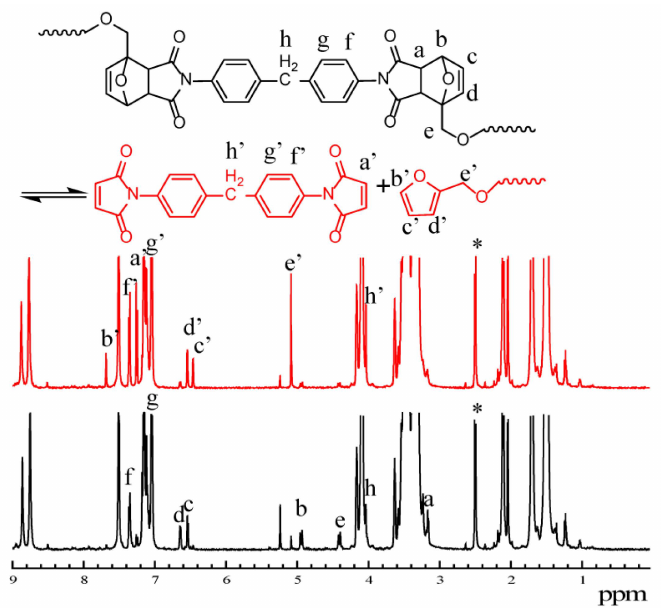
Figure 7. 1 H NMR spectra of PET-DA-PU during the heating procedure at 100 ◦ C for 20 min. (PET-DA- PU was marked as black, and PET-DA-PU after heat treatment was marked as red, ‘*’ for DMSO-d 6